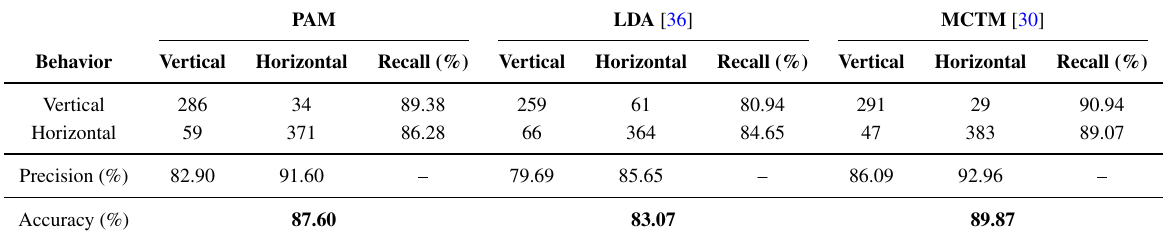
Table 9. Behavior classification comparison between PAM and LDA.